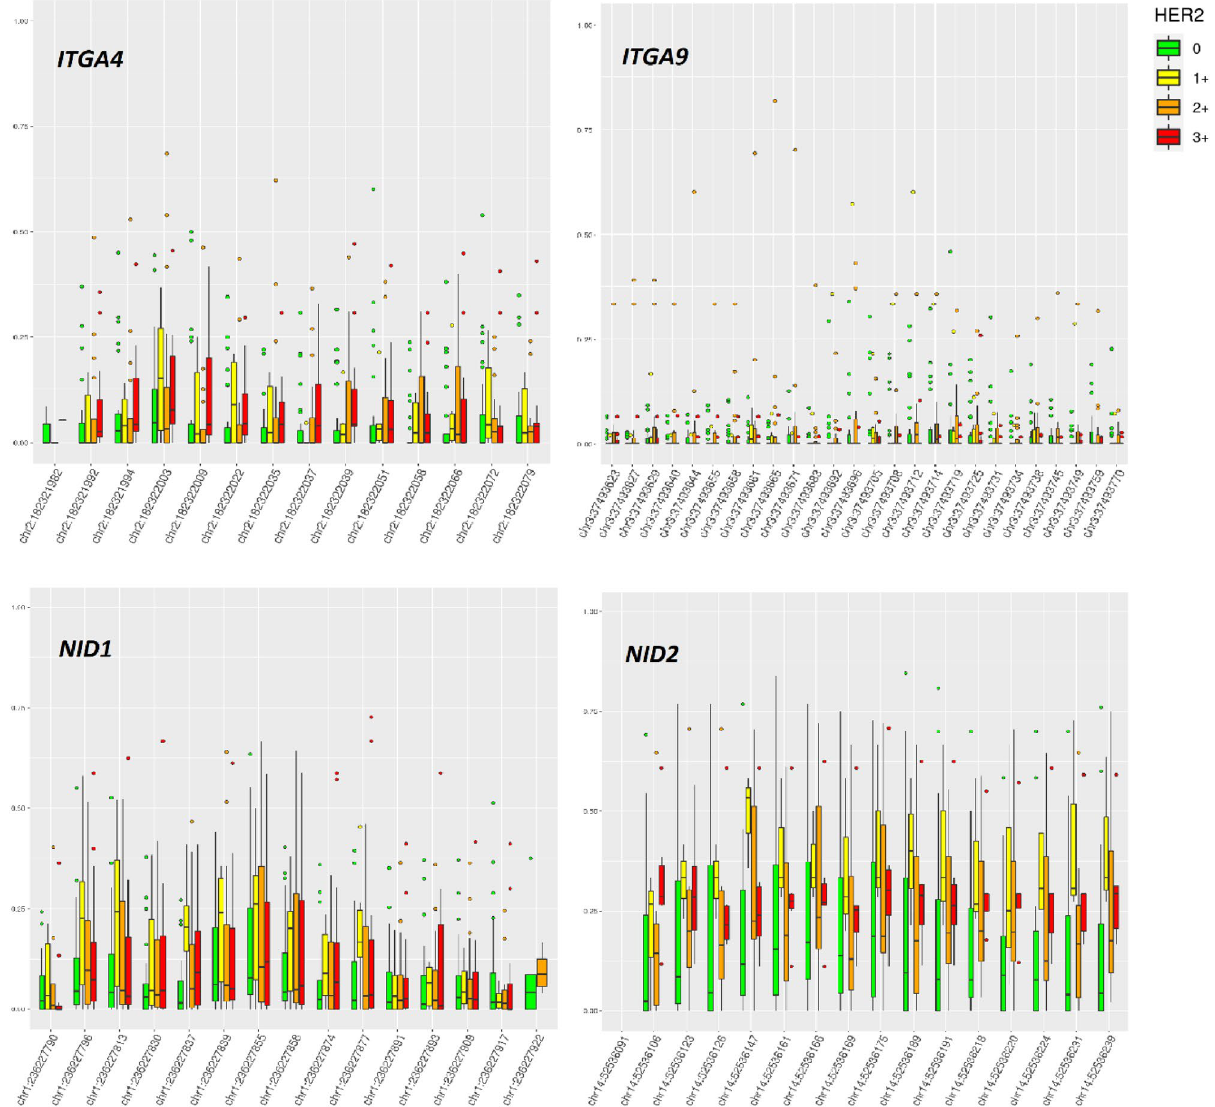
Figure 5. Relative fractions of methylated and nonmethylated alleles, measured in breast cancer samples by XmaI-RRBS, in respect to HER2 expression. Beta values ranging from 0.00 for totally nonmethylated to 1.00 for totally methylated (along the Y-axis) are the estimate of methylation level, and is the fraction of methylated CpG dinucleotides in all CpG dinucleotides assessed in genomic (GRCh37/hg19) positions indicated along the